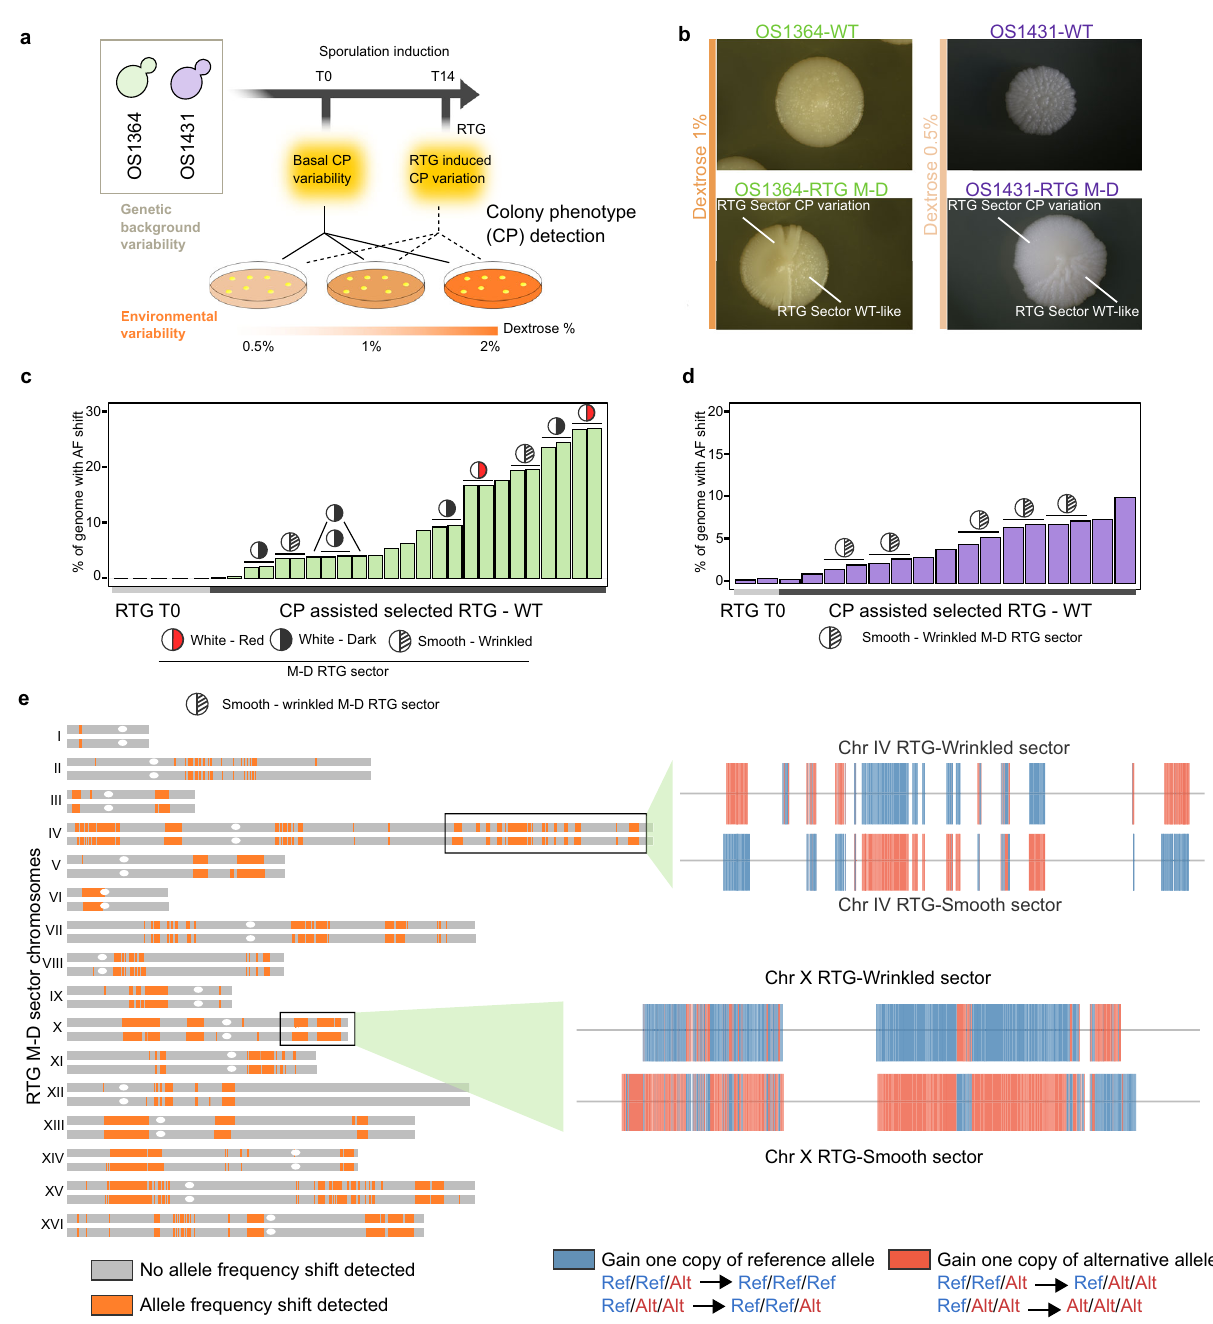
Gain one copy of alternative allele Ref/Ref/Alt Fig. 3 Colony phenotyps revealed mother-daughter RTG pairs. a Varying dextrose concentrations unveiled hidden colony phenotypic variation upon RTG. b Wild-type (WT) colony phenotypes (top) and sectored phenotypes emerging on RTG plates (bottom). The concentration of dextrose in the media is reported on the left. c The percentage of markers with allele frequency (AF) shift in the OS1364 derived RTG samples. The mother-daughter pairs for which both sectors were sequenced are indicated (circles). Single samples represent non-sectored RTG colonies ( n = 4) or only one-side of a RTG sectored colony ( n = 3). d As in c for the OS1431 background. e Recombination map of a RTG M-D pair (top chromosome: sm244/ bottom chromosome: sm245, derived from OS1364). Grey regions indicate the heterozygous markers without AF shifts, whereas orange regions contain heterozygous markers with AF shifts underlying recombination events. A zoom-in of two recombined regions is illustrated on the right. Colours represent the changes in genotype ratio of heterozygous markers. The lack of completely phased haplotype generates a fragmented AF shift pattern although this might derive from a longer continuous recombination event (Methods). Source data are provided as a Source Data fi fi nd any shared AF shift region among the respective RTGs during RTG. Thus, we concluded that the sectored RTG colonies derived from OS1364 or OS1431. Second, we observed a were indeed M-D pairs and we exploited the recombination complementary gain and loss of one chromosome in one M-D generated by RTG in OS1364 M-D RTGs to produce phased local pair derived from OS1364 (Supplementary Figure 7b), which is haplotypes showing a potential application of RTG in polyploid compatible with chromosome missegregation between M-D yeasts (Supplementary Figure 7c).